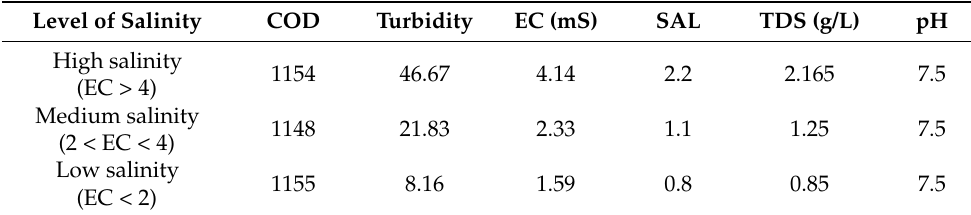
Table 2. Characteristics of synthetic dairy wastewater (SW-BSA) with various salinity levels.